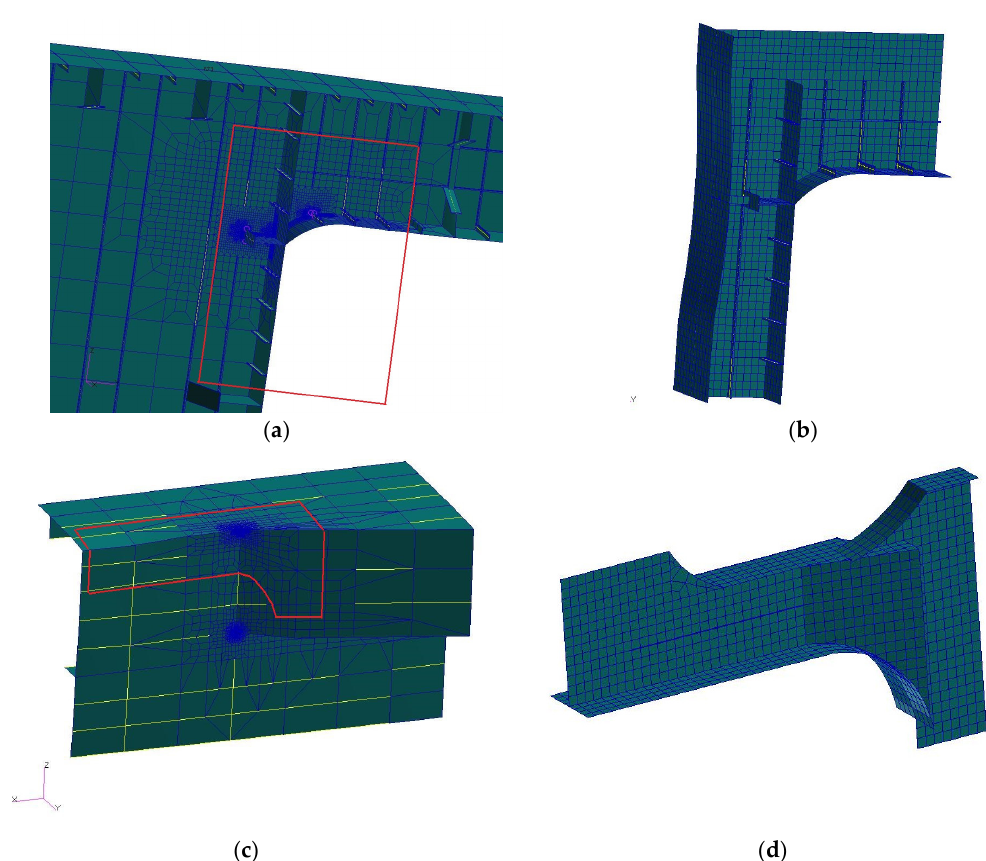
Figure 4. Scope of full-scale models as follows: ( a ) Detail 2, ( b ) Model 1, ( c ) Detail 1, and ( d ) Model 2. The principle dimensions of model 1 are L × B × D = 2.38 m × 0.40 m × 1.59 m, and the principle dimensions of model 2 are L × B × D = 2.38 m × 0.40 m × 1.34 m. The number of full-scale model 1 is